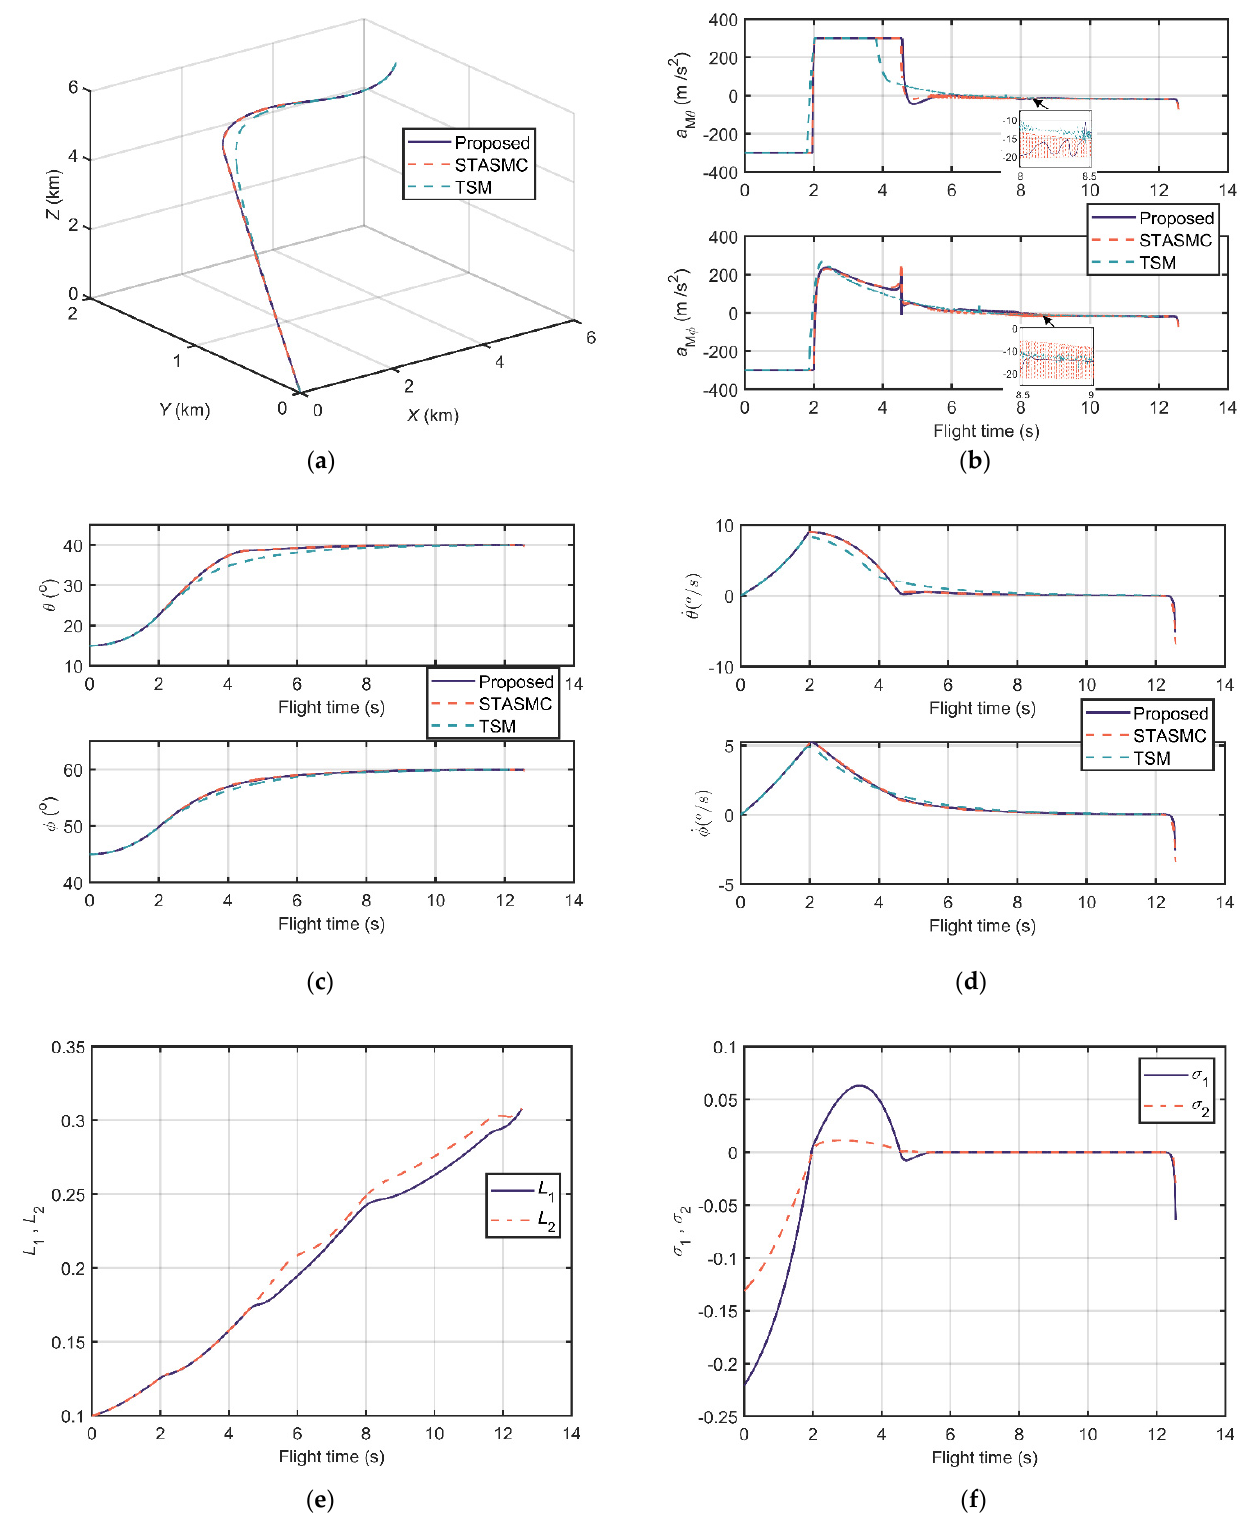
Figure 9. Comparison results of scenario 2: ( a ) Relative distance trajectories; ( b ) Output accelerations of guidance loops; ( c ) LOS angles; ( d ) LOS angular rates; ( e ) The adaptive STA gains; ( f ) The sliding manifold. Moreover, other information including flight time, miss distance, settling time ( ± 0.5 ◦ ), and error of LOS angles is listed in Tables 3 and 4. Miss distance states the distance between missile and target at the end. Settling time ( ± 0.5 ◦ ) indicates the time that LOS angles